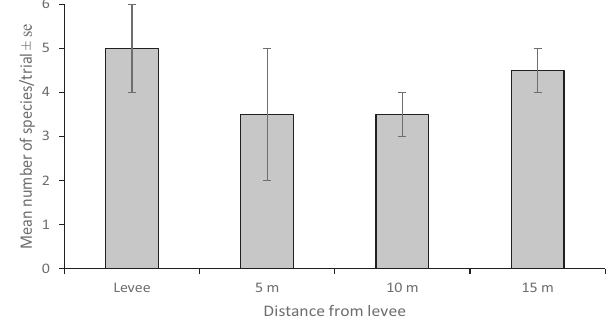
Fig. 2. The number of identified cricket (Gryllidae) species in a riparian paddy field near Mount Fuji at differing distances from a levee (after Ichihara et al.